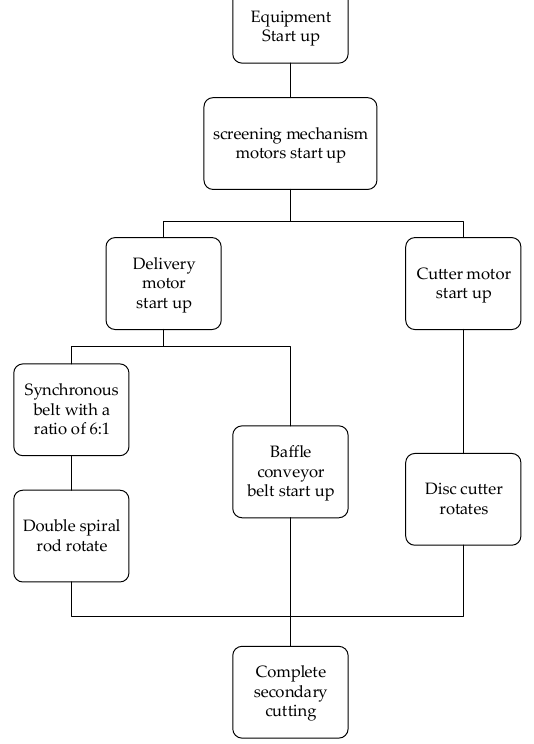
Figure 17. Control flow chart of broccoli secondary cutting equipment.